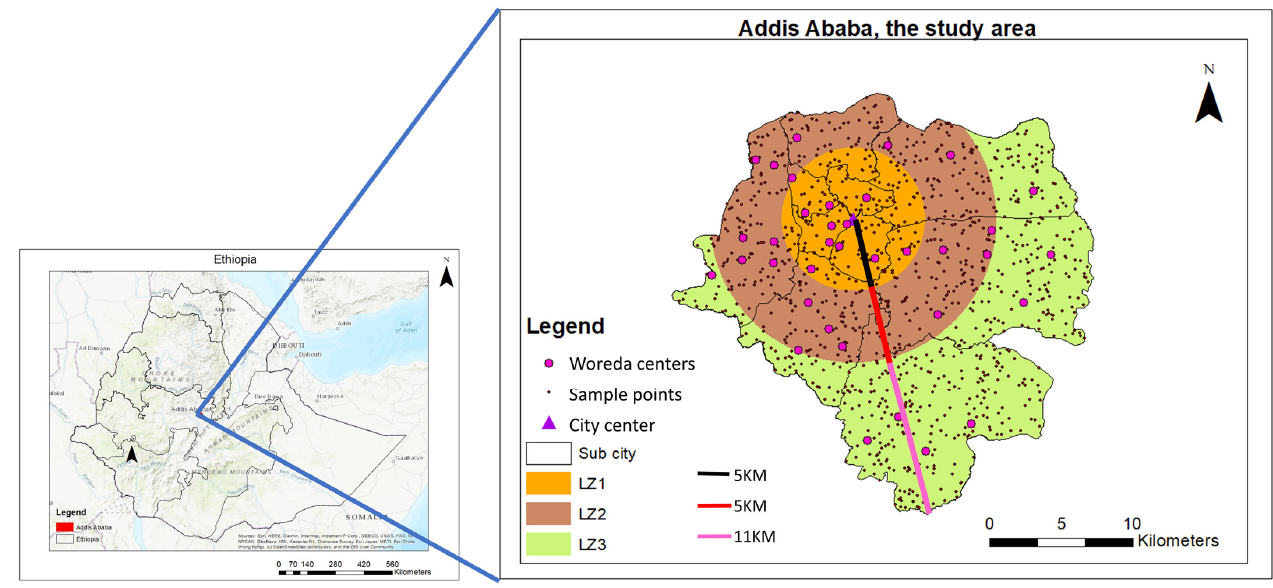
Figure 2. The study area (the capital of Ethiopia, Addis Ababa) geographically located within the central highlands of the country. The city is divided into three land zones: at every 5 km for the first two land zones and at the 11th km for the third land zone. The Woreda is the smallest official administration unit and equivalent to a district, and LZ refers to land zone. The city’s economic center is based on the municipality’s designation.